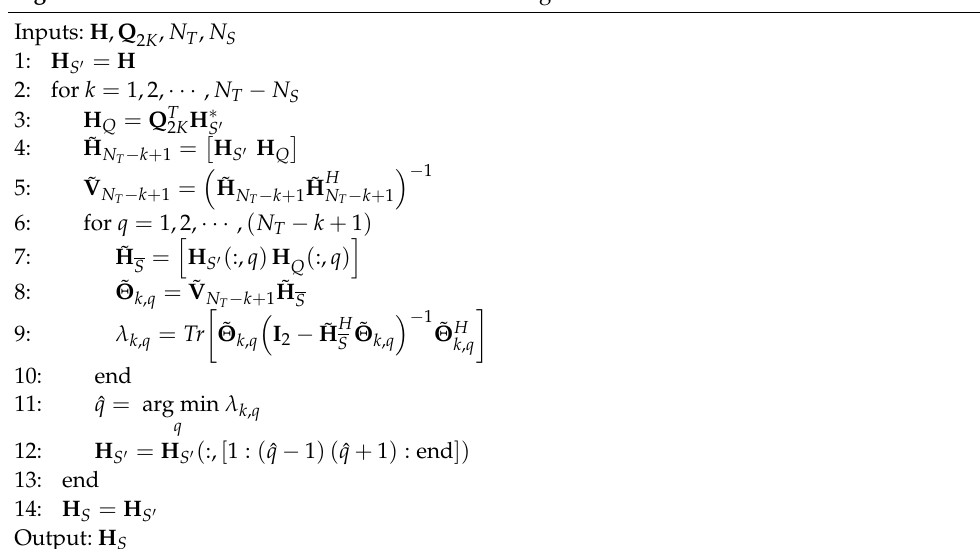
Algorithm 3 SNR-based decremental TAS selection